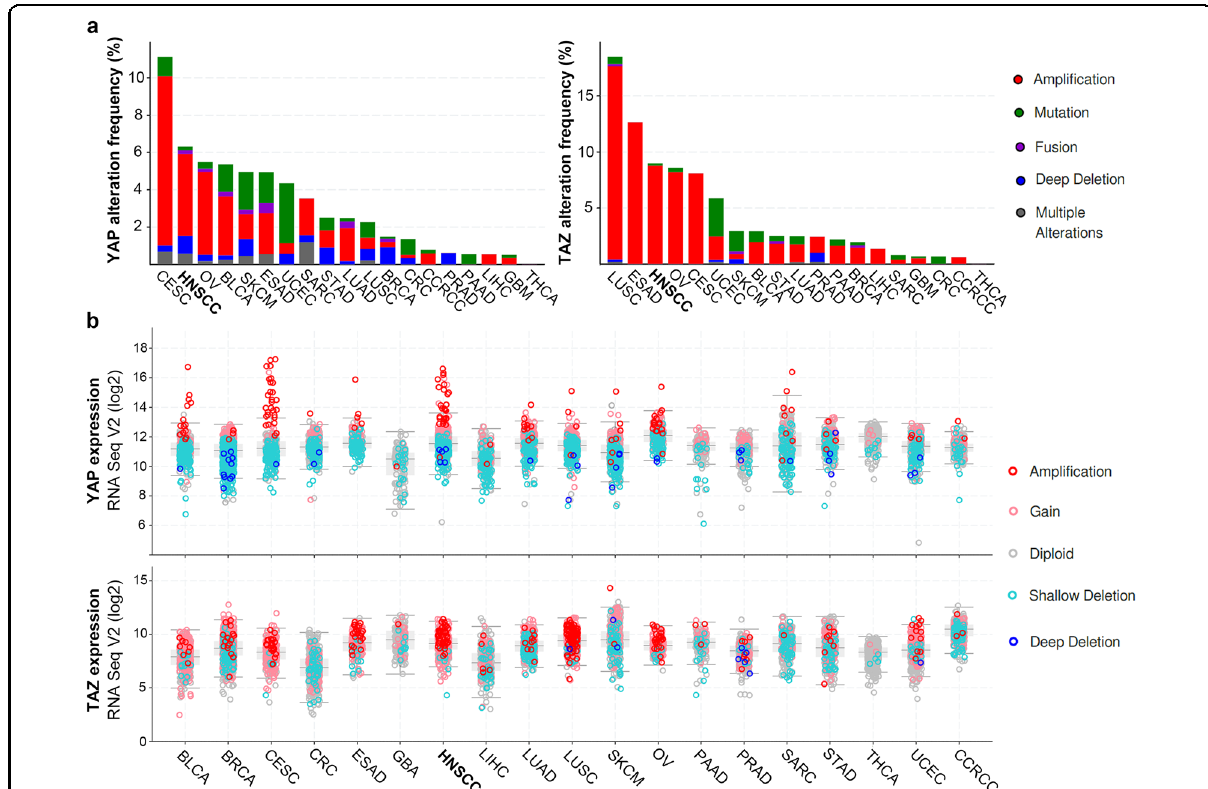
Fig. 2 Genetic alteration in and expression of YAP and TAZ in human cancers. a The frequency of alterations in YAP and TAZ in different cancer types. b YAP/TAZ mRNA expression (RNA Seq V2) in various types of cancer. Each color represents different types of somatic alterations. TCGA PanCancer Atlas data were retrieved with cBioPortal. CESC cervical squamous cell carcinoma, HNSCC head and neck squamous cell carcinoma, OV ovarian serous cystadenocarcinoma, BLCA urothelial bladder cancer, SKCM cutaneous melanoma, ESAD esophageal adenocarcinoma, UCEC uterine corpus endometrial carcinoma, SARC sarcoma, STAD stomach adenocarcinoma, LUAD lung adenocarcinoma, LUSC lung squamous cell carcinoma, BRCA breast invasive carcinoma, CRC colorectal adenocarcinoma, CCRCC clear cell renal cell carcinoma, PRAD prostate adenocarcinoma, PAAD pancreatic ductal adenocarcinoma, LIHC liver hepatocellular carcinoma, GBM glioblastoma, THCA thyroid